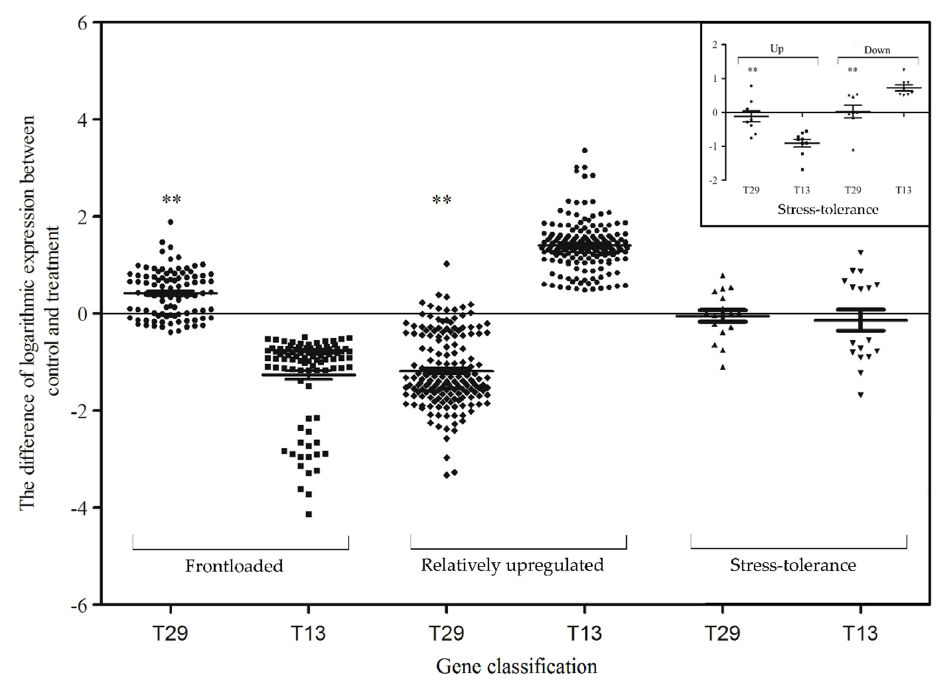
Figure 4. Scatter plot of expression of genes between high-NUE T29 and low-NUE T13, unique to the T13_T vs. T13_C. The difference of logarithmic expression between control and treatment is shown on the vertical axis ln(T29_C/T29_T) and ln(T13_C/T13_T); the types of differentially expression genes are shown on the horizontal axis. The small figure shows the up- and downregulated details of stress-tolerance genes in T13. ** indicates significant difference between the two genotypes at p < 0.01, vertical error bars represent mean ± SD.